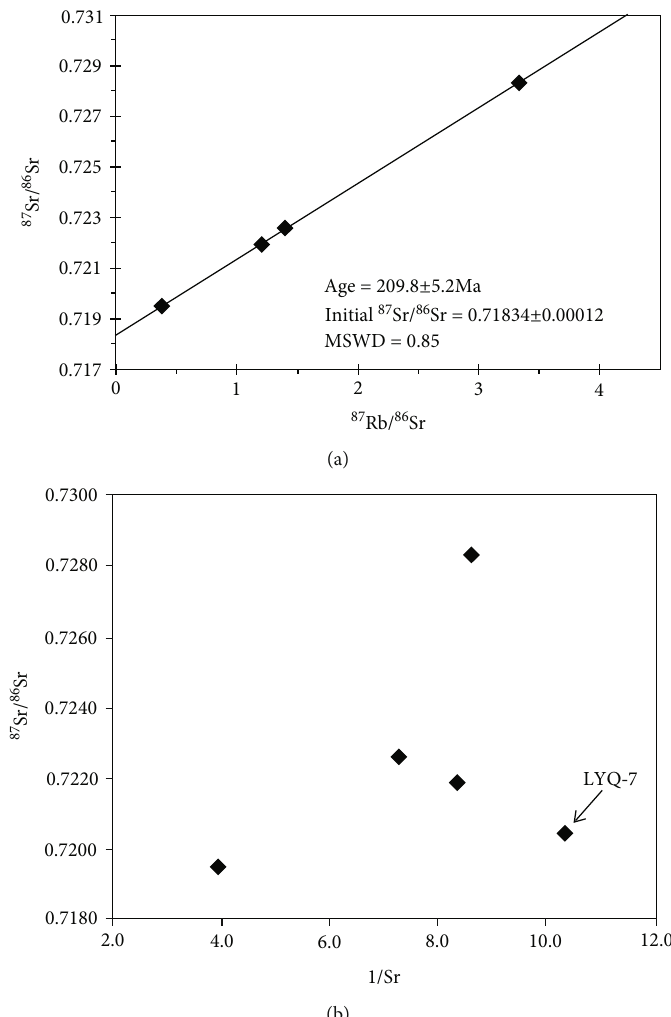
Figure 5: Plot of sul fi de Rb – Sr isochron for the Laoyingqing Pb – Zn deposit (a) and plot of sul fi de 87 Sr/ 86 Sr vs. 1/Sr for the Laoyingqing Pb – Zn deposit (b). Table 4: Sulfur isotopic compositions of sul fi des from the Laoyingqing Pb – Zn deposit. Sample